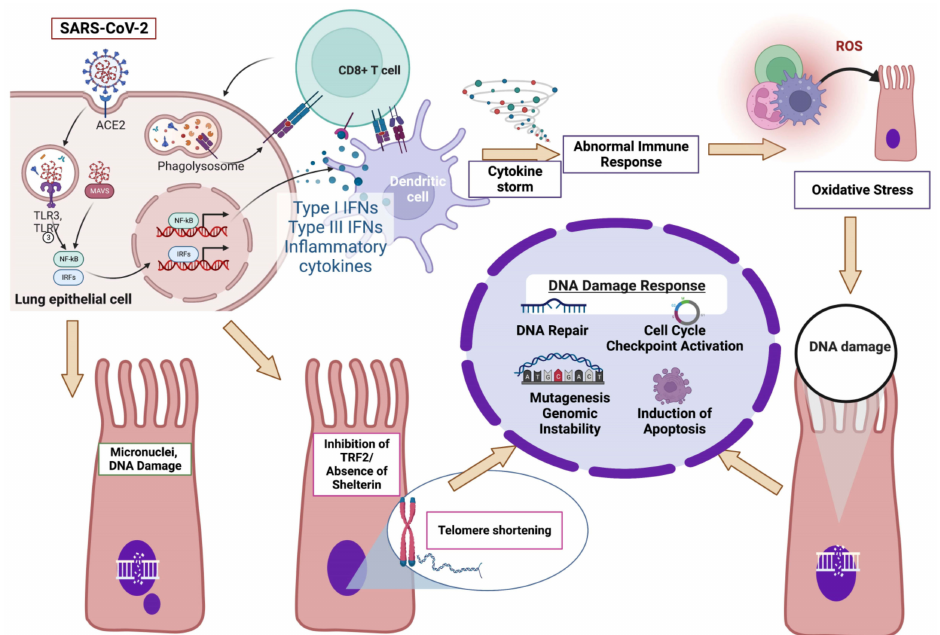
Figure 2. SARS-CoV-2-induced abnormal activation of the DDR network: a proposed model